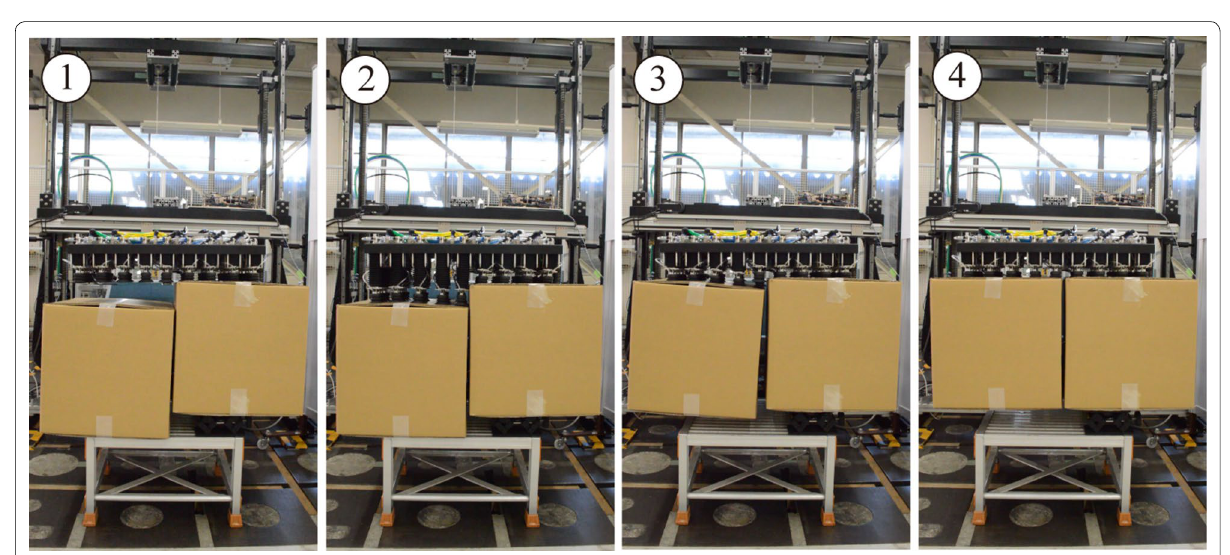
Fig. 27 Experimental situation for cardboard boxes with height differences: 85